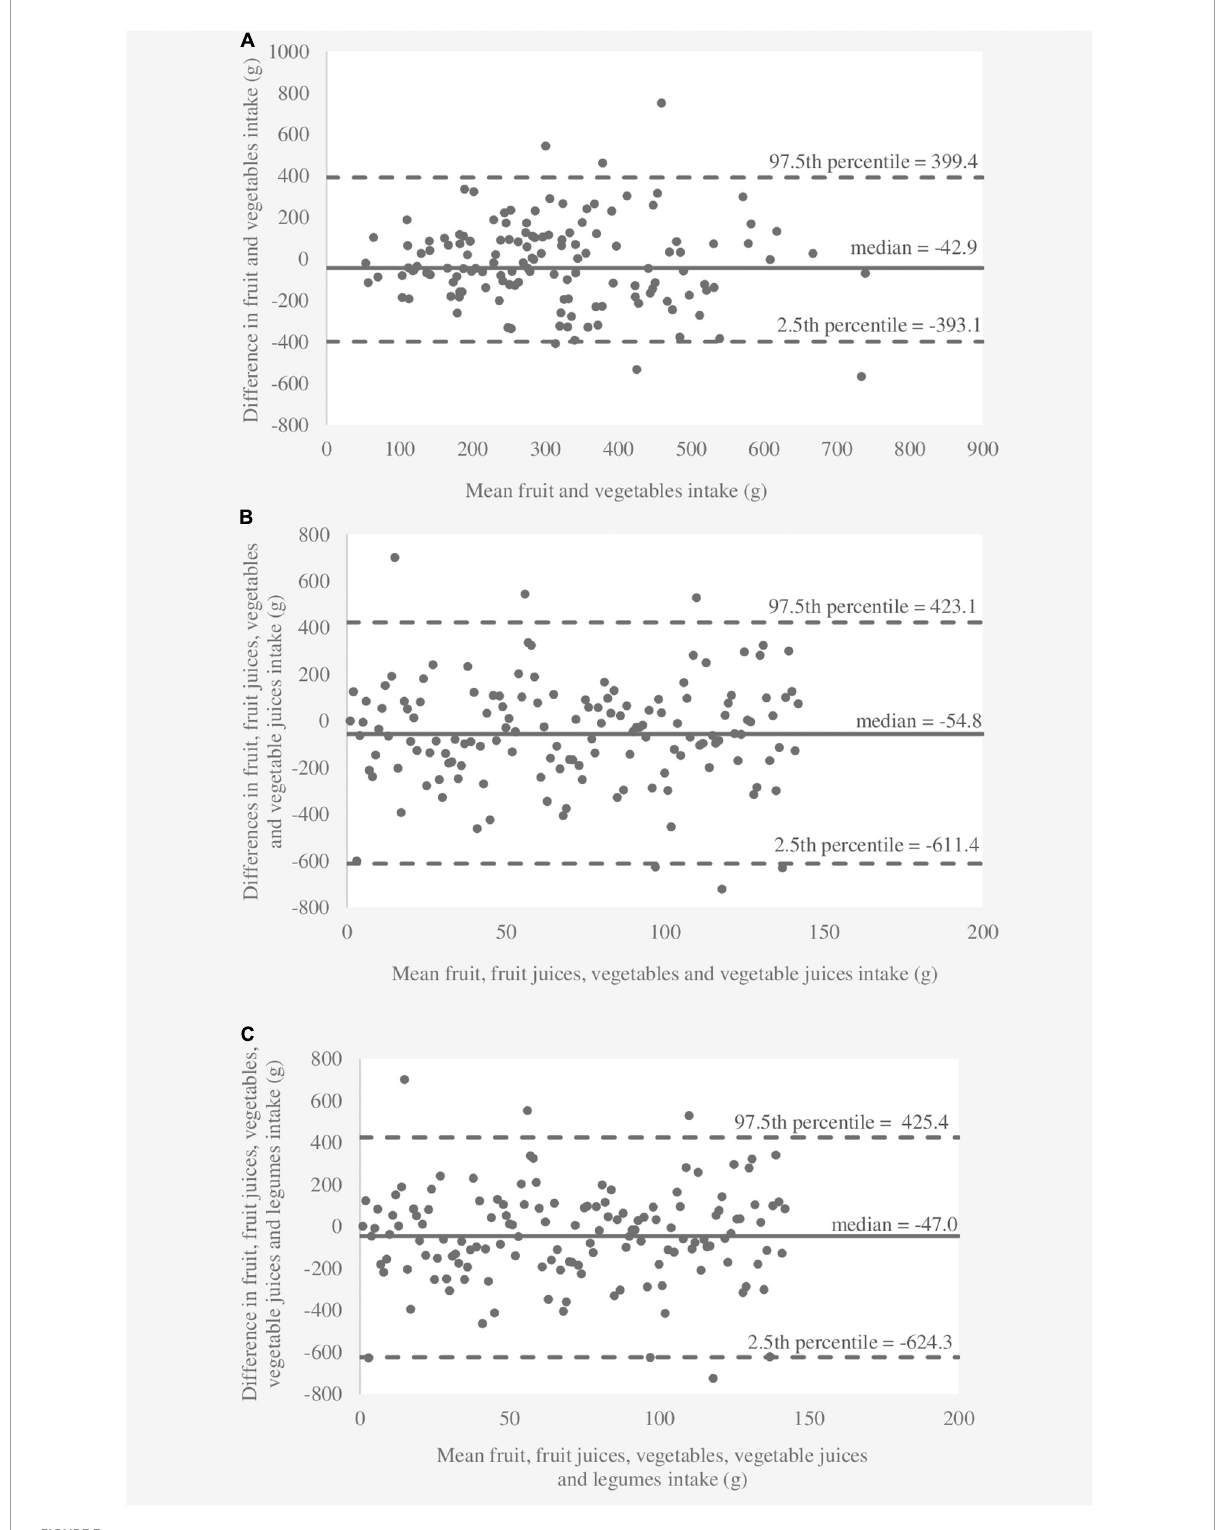
FIGURE3 Bland–Altman plots showing agreement between the 3-day dietary records and the first food frequency questionnaire for consumption of (A) “fruit and vegetables,” (B) “fruit, fruit juices, vegetables, and vegetable juices,” and (C) “fruit, fruit juices, vegetables, vegetable juices, and legumes” per